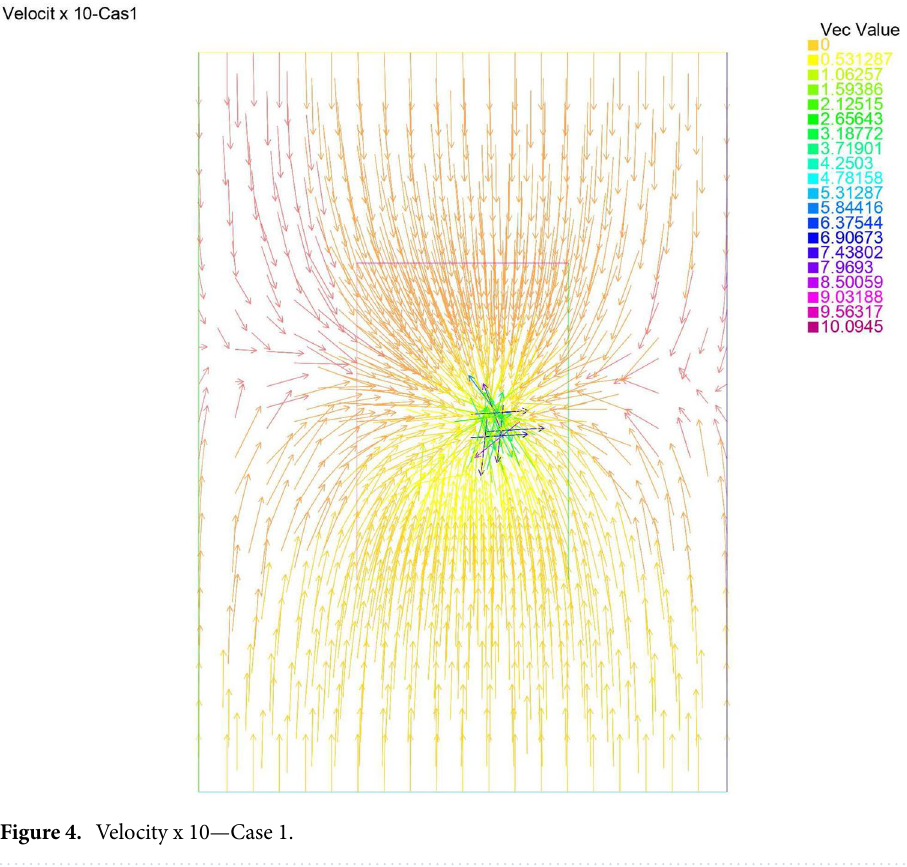
Figure 4. Velocity x 10—Case 1.